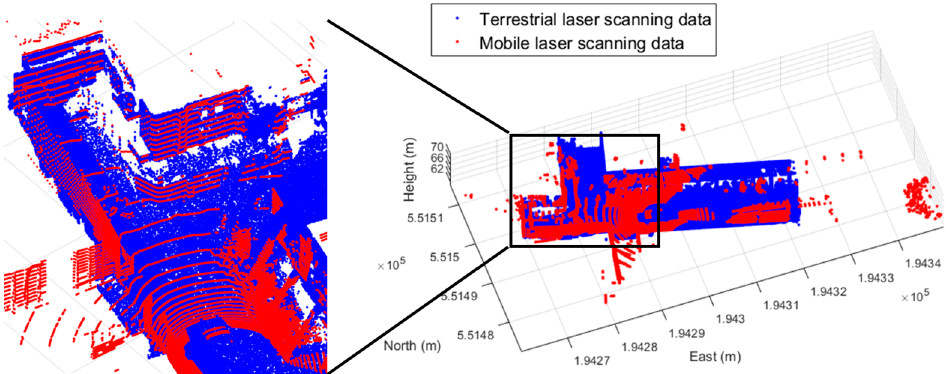
Figure 14. Georeferenced mobile laser scanning data.